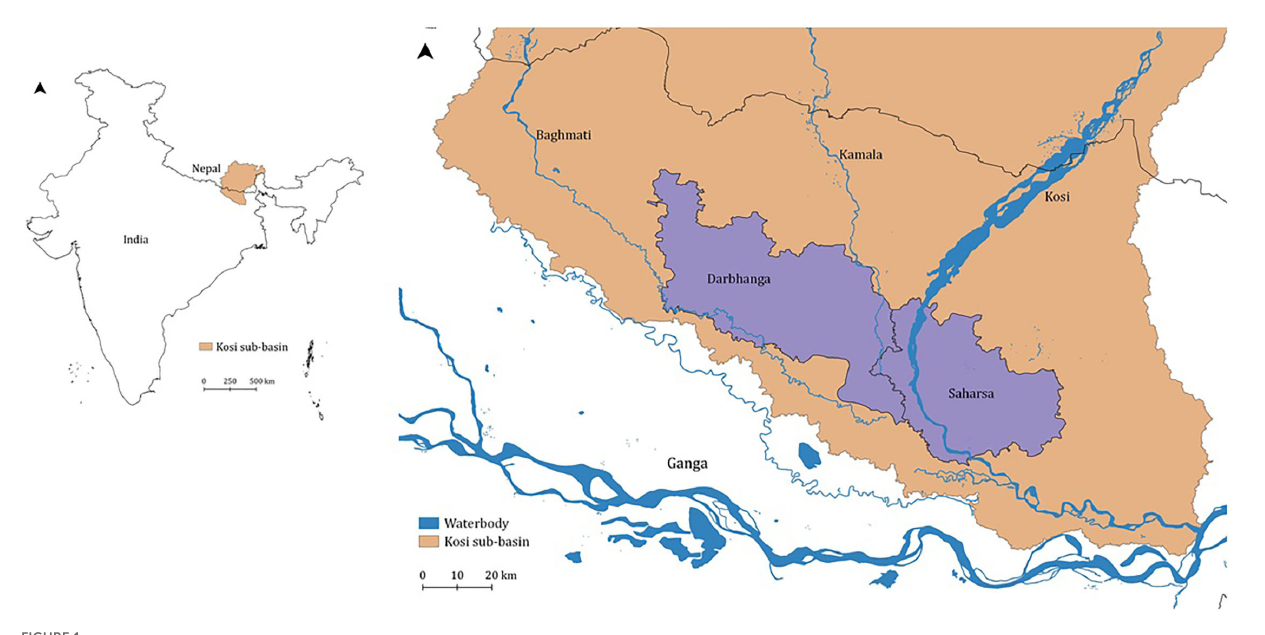
FIGURE1 Location map of study area-Darbhanga and